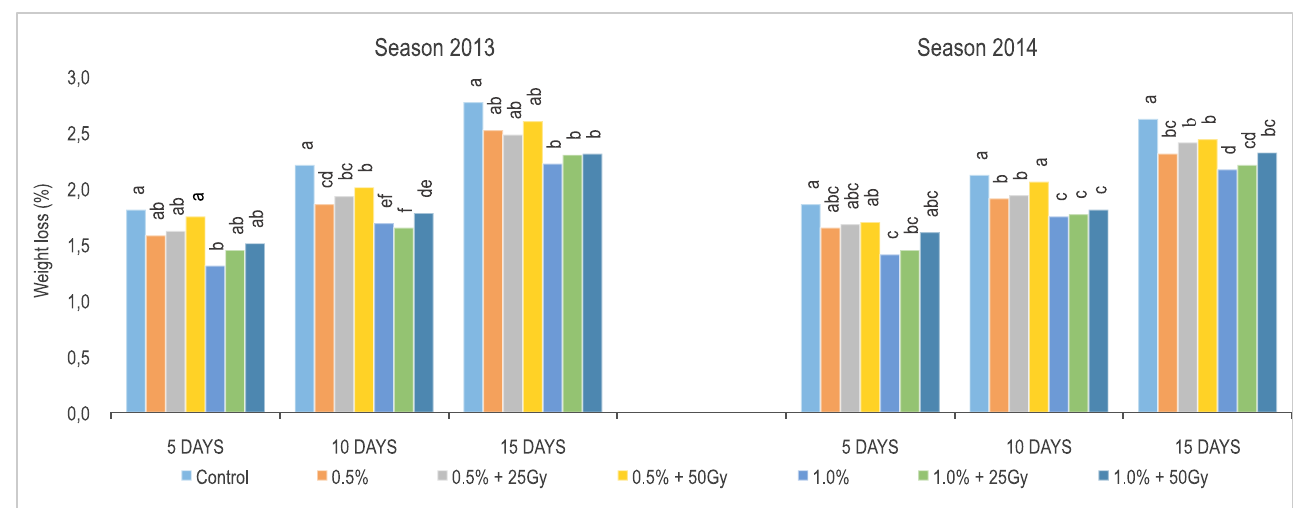
Fig. 1: Effect of irradiated and unirradiated chitosan on arils weight loss (%) during cold storage. Columns in the same group bearing a common letter are insignificantly different at P<0.05.